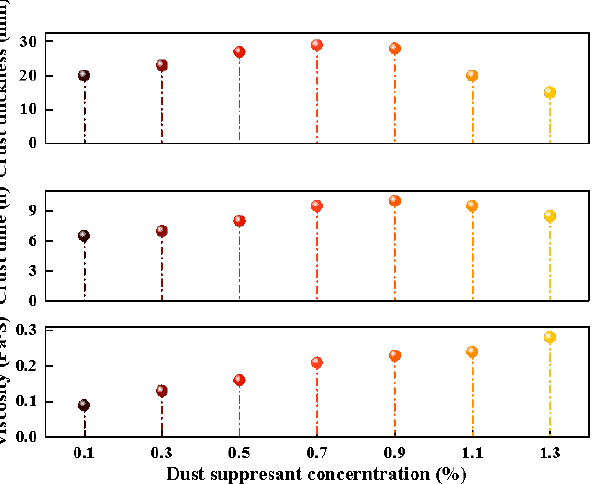
Figure 8. Viscosity, crusting time, and crusting thickness of different concentrations of dust sup- pressants.